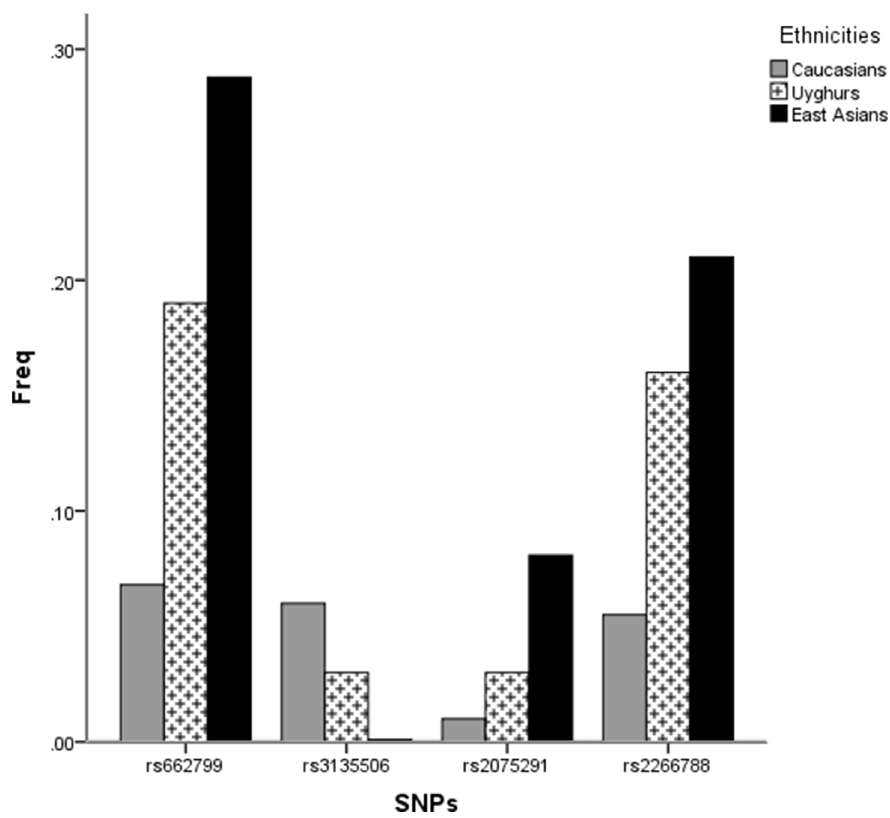
Figure 2. The minor allele frequencies (MAFs) of the polymorphisms in APOA5 in the different populations. Based on the online databases and literatures in addition to our own